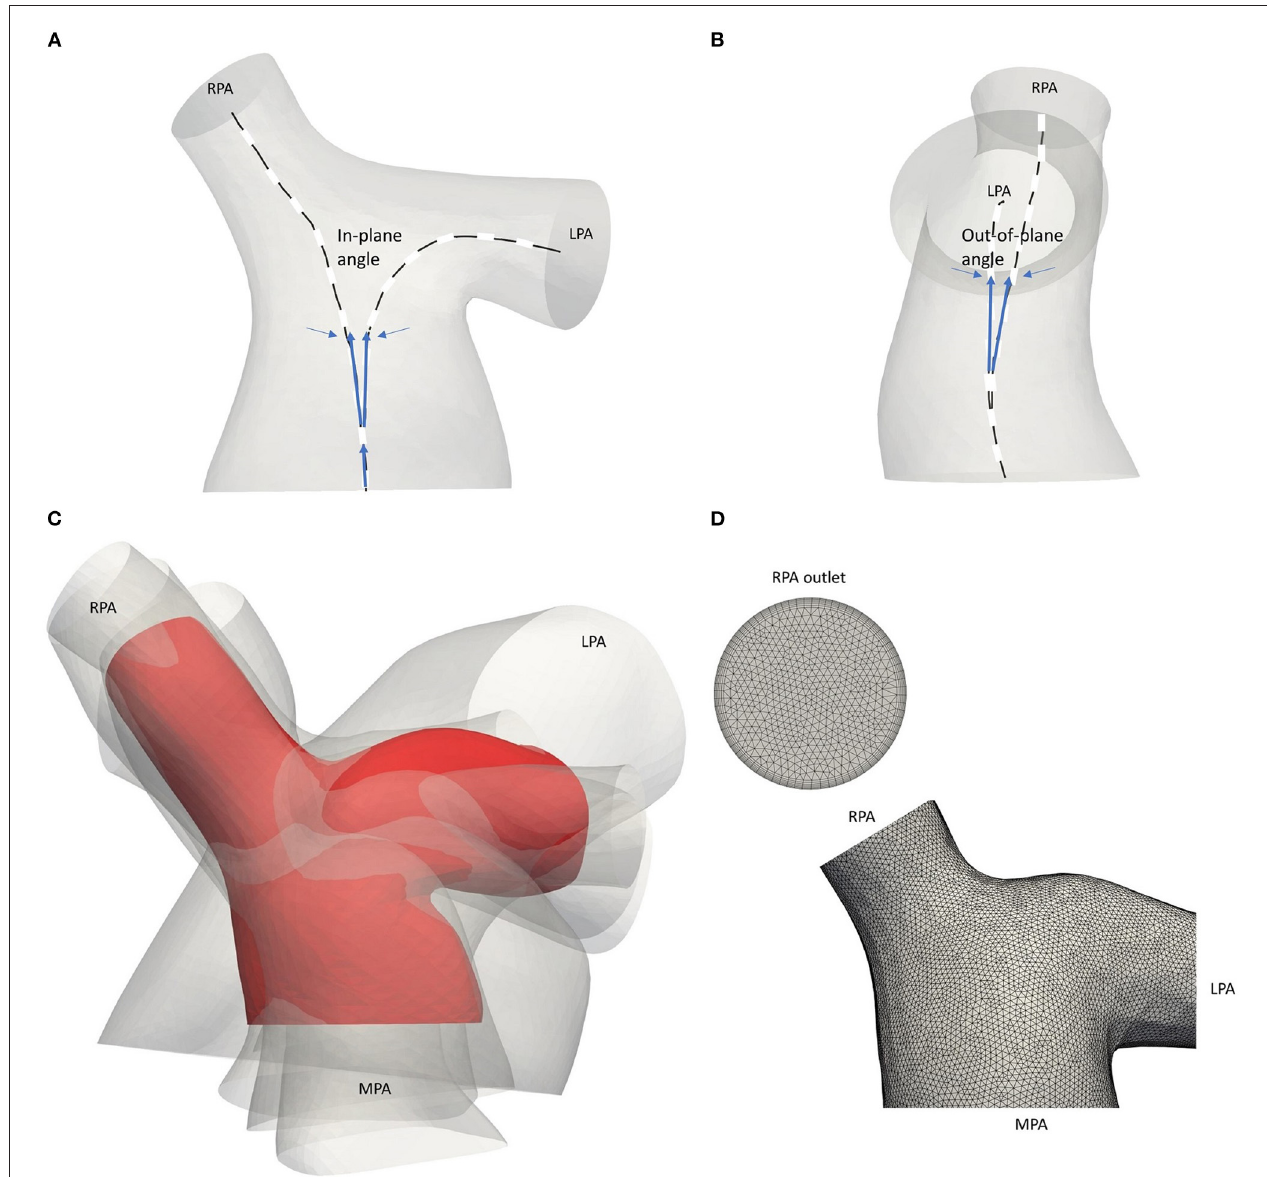
FIGURE 3 | Schematic representation of the (A) in-plane and (B) out-of-plane angles. (C) Average geometry of the five adult TOF patients (red) with the patient-specific models shown transparent. Models are co-registered based on point O of Figure 1B . (D) Computational mesh of the average geometry around the pulmonary junction. The boundary layer at the RPA outlet is also